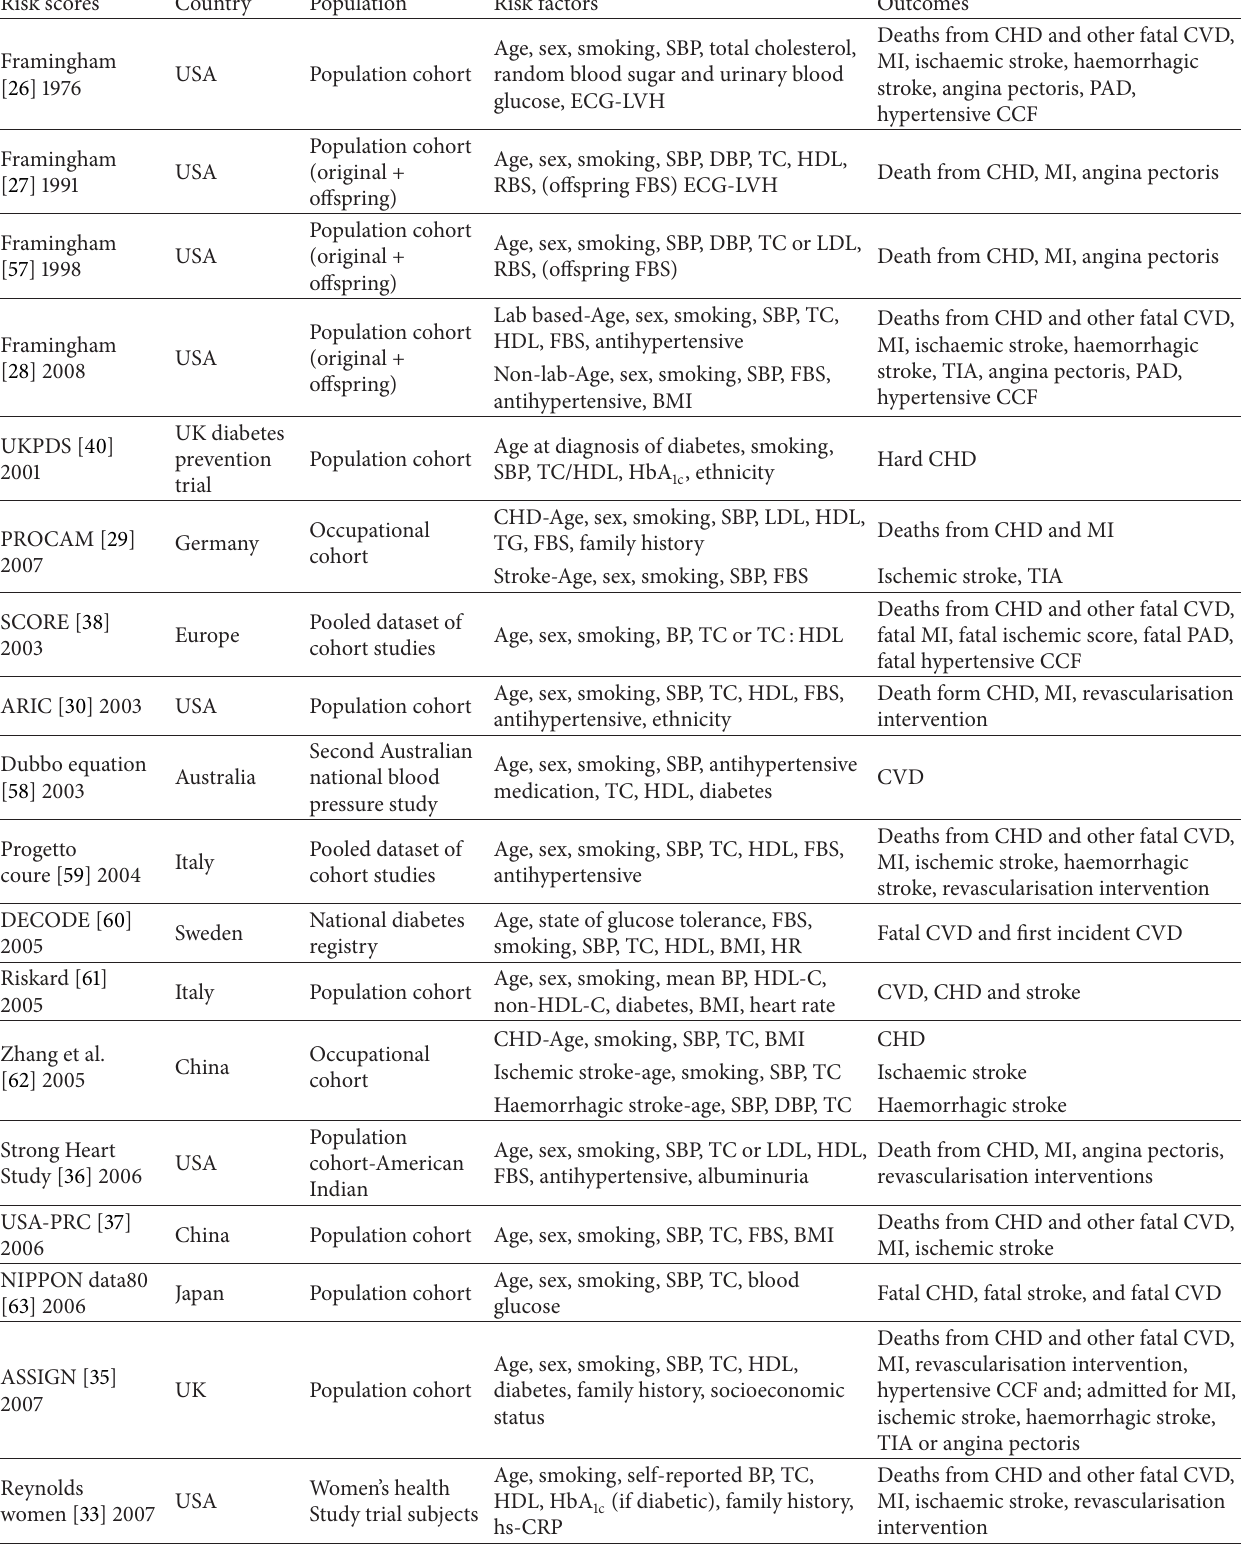
Table 3: Key characteristics of important cardiovascular risk